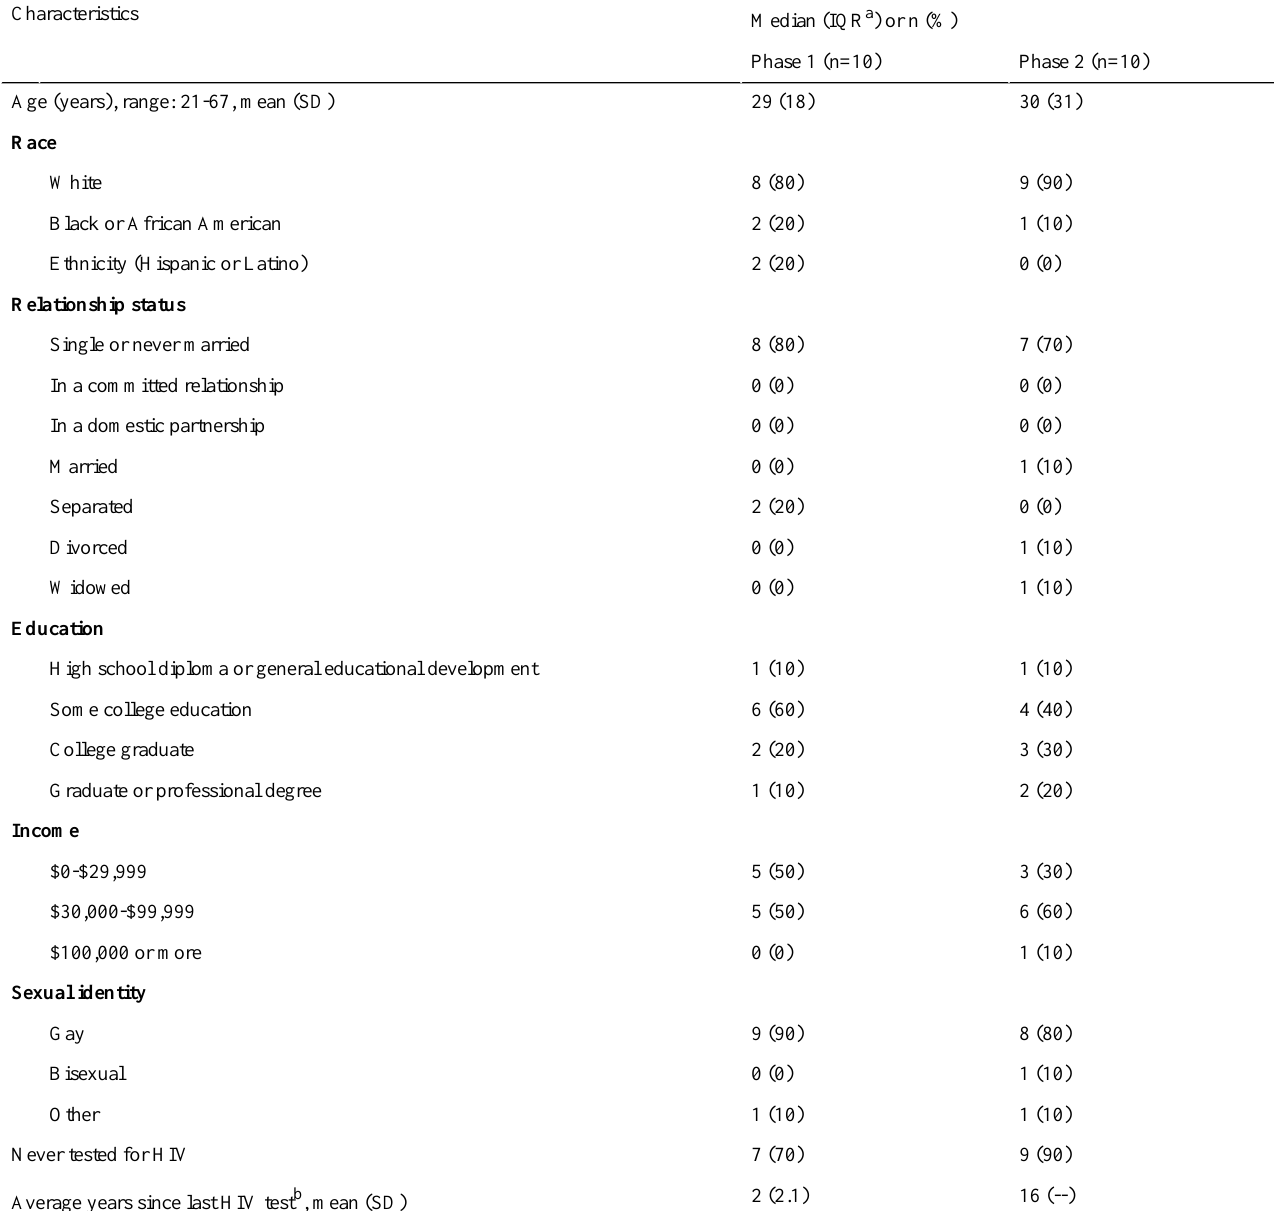
Table 1. Participant demographic